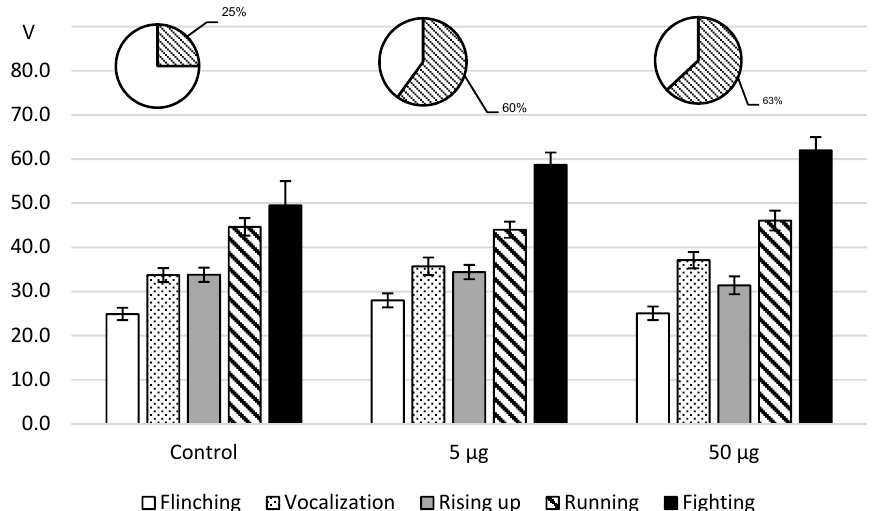
Figure 4. The thresholds values of rat aggressive-defensive behavior (V, M ± m) in the foot-shock test after intracerebroventricular L-lysine administration. Note: the obtained data were analyzed by ANOVA and the post hoc Dunnett test; the round diagrams: the fighting rate (shaded) as a percentage of the total number of samples: two stimulation tests were carried out on each of ten rats in pairs (all samples — to 20).